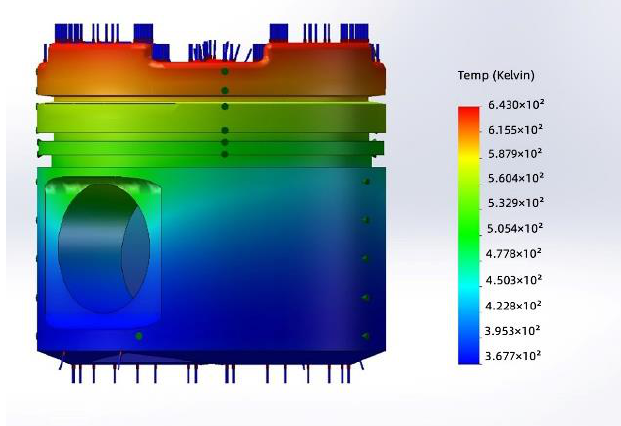
Figure 7. SEM micrograph of the cylinder liner surface. The temperature distribution of the piston skirt, based on a typical bench test, is shown in Figure 8. It was found that the temperature of the piston skirt ranged from 90 to 150 ◦ C. Accordingly, the temperature was set to 120 ◦ C for the friction and wear test in this study.